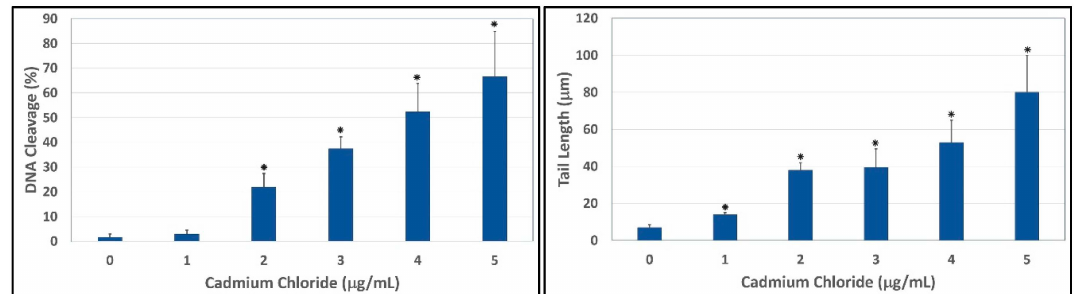
Figure 4. Comet assay of HepG 2 cells showing the percentages of DNA cleavage ( Left ) and comet tail lengths ( Right ) as a function of cadmium chloride concentrations. Each point represents mean ˘ SD of three independent experiments. * Significantly different ( p < 0.05) from the control, according to the Dunnett’s